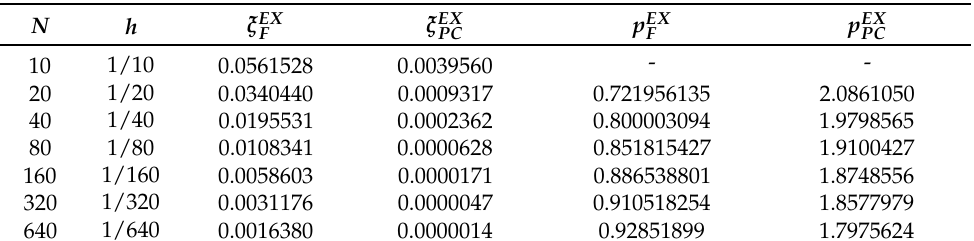
Table 1. Error analysis of numerical methods ENFDS and ABM for β = 1.8, γ = 0.9 taking into account the exact solution